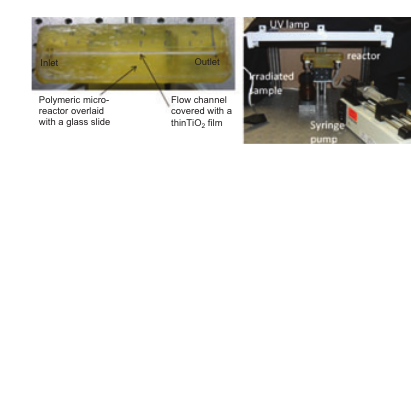
processesProcess Process n